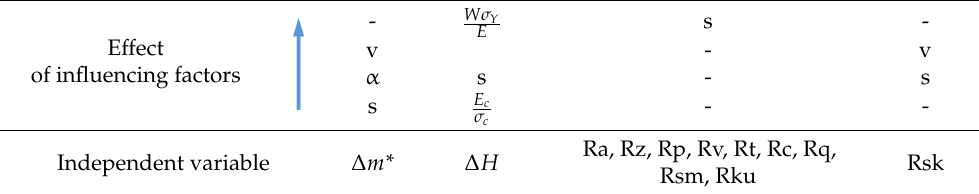
Table 23. Abrasive sensitivity ranking to slurry pot system